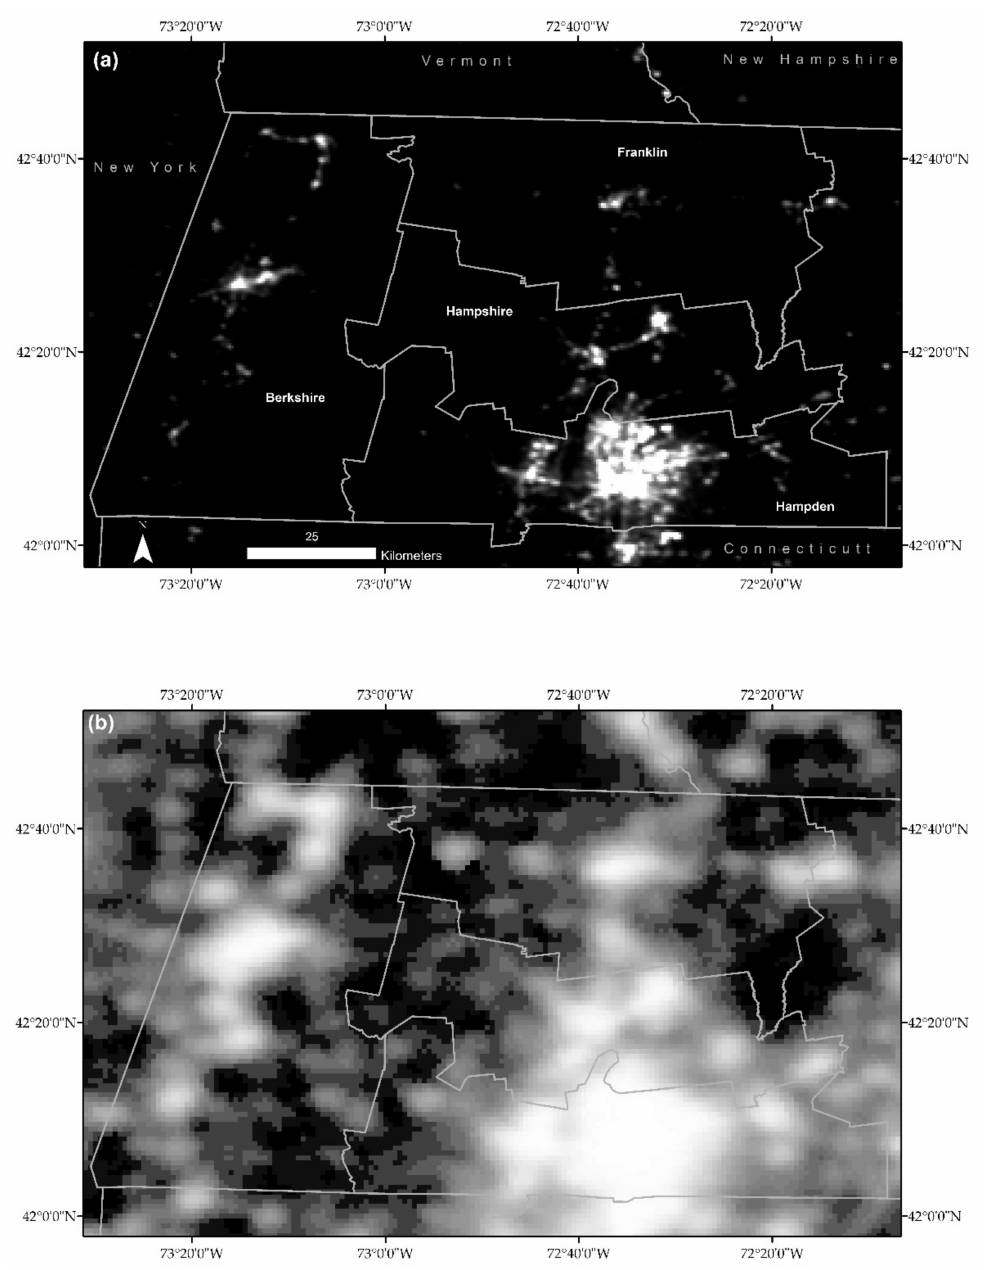
Figure 3. Night lights of western Massachusetts according to ( a ) V.2 VNL masked average radiance in 2014 and ( b ) DMSP stable lights in